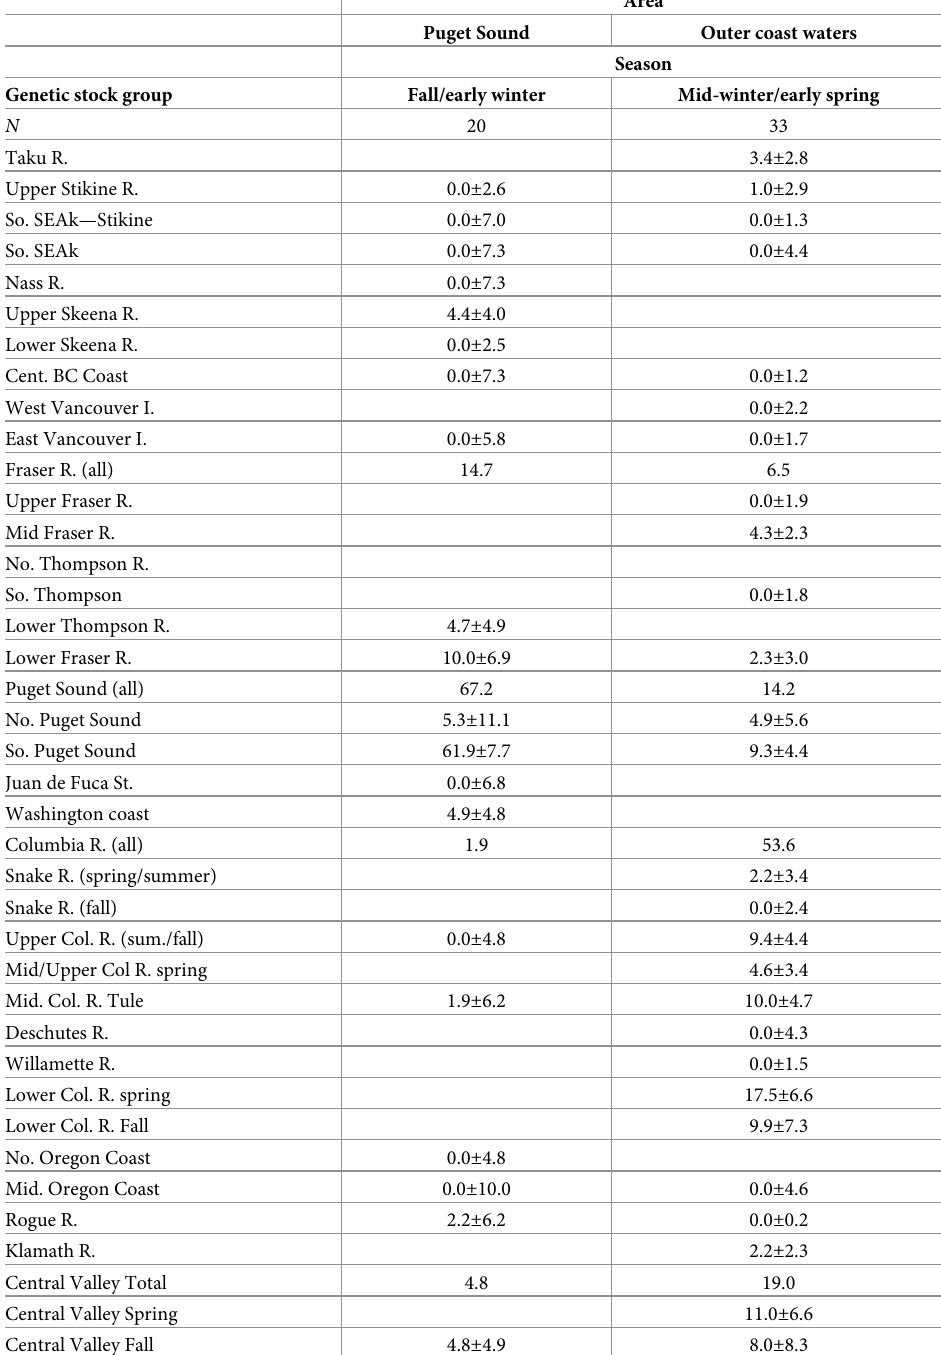
Chinook genetic stock groups are arranged from north to south. Chinook populations from [26], Appendix